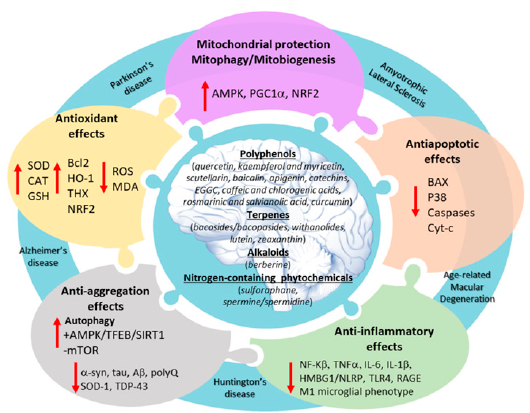
Figure 1. A general overview of the mechanisms of action of phytochemicals in neurodegenerative diseases. Intermingled as pieces of a puzzle, the multi-target effects of phytochemicals in the brain include anti-oxidant, mitochondrial protecting, anti-apoptotic, anti-aggregation, and anti-inflammatory activity. Oxidative stress results from a decrease in the antioxidant system’s response coupled with increased production of ROS, including free radicals such as superoxide anion (O 2 − ) and hydroxyl radical (OH), and also non-radical species such as hydrogen peroxide (H 2 O 2 ), singlet oxygen ( 1 O 2 ), and so forth. Oxidative stress, that is, when the level of intracellular ROS exceeds the defense mechanisms, represents a common hallmark of various brain disorders, ranging from psychiatric to neurological and vascular-related brain disorders [3,7,10,13–17,19,25,32,128]. Persistent and sustained oxidative stress may contribute to neuronal injury through ROS-mediated oxidative damage at the level of various biomolecules, including proteins, lipids, and nucleic acids within neurons and glia. The deleterious effects of ROS in the brain are bound to the abundance of polyunsaturated fatty acids, transition metal ions, and also to the high metabolic rate of excitatory and oxidation-prone neurotransmitters, such as dopamine and glutamate, which makes brain cells highly susceptible to ROS-mediated damage [129]. In the last decades, the search for an effective and potentially safe strategy to combat oxidative stress-mediated neuronal damage has increasingly prompted the investigation of naturally occurring compounds as antioxidant agents. The attenuation of oxidative stress by bioactive compounds belonging to different classes of phytochemicals including (i) flavonoids (quercetin, kaempferol and myricetin, scutellarin, baicalin, apigenin, catechins, epigallocatechin, and genistein) [52,61,81–83,88,94,130–137]; (ii) phenolic acids (syringic, gallic, caffeic, chlorogenic and salvianolic acids, and curcumin) [70,103–105,138–143]; (iii) flavonolignans (silymarin) [96]; (iv) stilbenes (resveratrol) [59,65,97,98,144]; (v) terpenes (bacosides/bacopasides, withanolides, and the carotenoids lutein and zeaxanthin) [7,110,113,115,145–147]; (vi) alkaloids (berberine and caffeine) [148,149]; (vii) glucosinolates (sulforaphane) and polyamines (spermine/spermidine) [123,124,150] have been associated with neuroprotection in both in vitro and in vivo models of ALS, PD, AD, ischemia/reperfusion, brain trauma/hemorrhage, AMD, and diabetic retinopathy, as well as H 2 O 2 -, lipopolysaccharide (LPS)-, pesticide-, and metal-induced neurotoxicity.